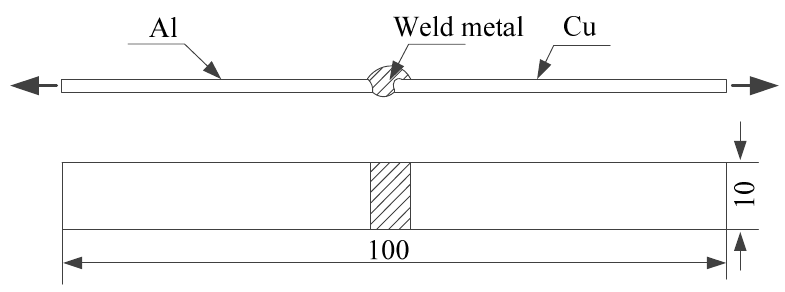
Figure 2. Dimensions of the tensile test sample (unit: mm).